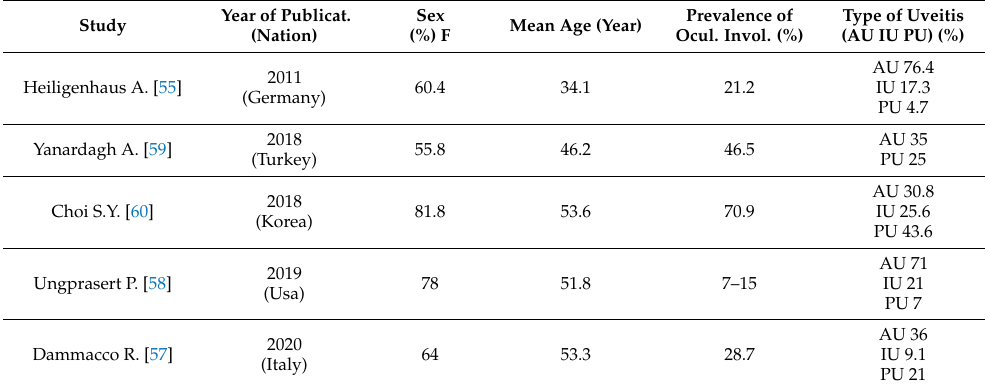
Table 1. The main OS epidemiological studies in recent literature showing sex, mean age, prevalence of ocular involvement and type of uveitis (Anterior Uveitis: AU; Intermediate Uveitis: IU; Posterior Uveitis: